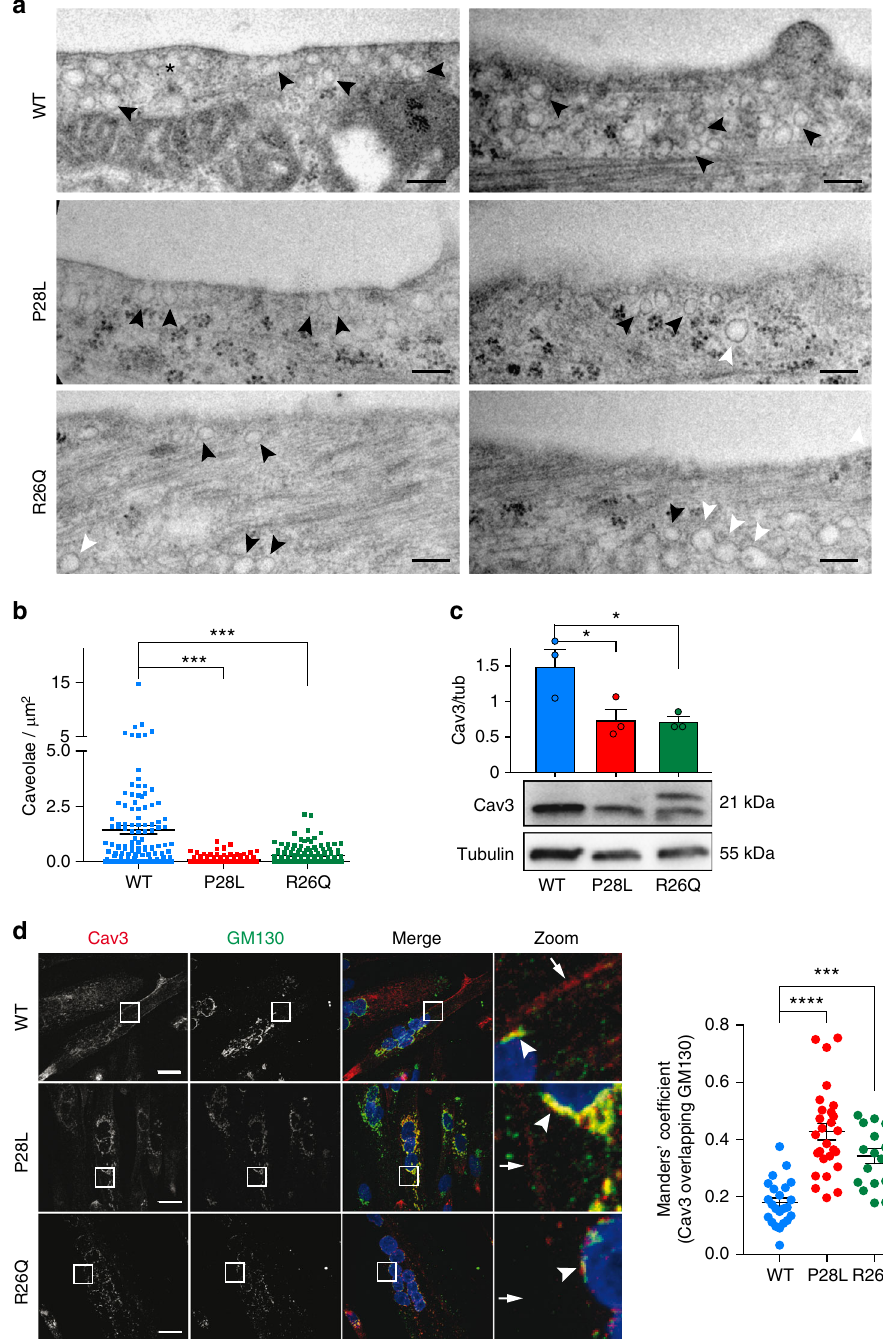
Fig. 1 Characterization of caveolae and Cav3 expression in WT, Cav3 P28L, and Cav3 R26Q myotubes. a Electron micrographs of WT, Cav3 P28L, and Cav3 R26Q myotubes. Caveolae, interconnected caveolae, and aberrant sized caveolae are indicated with black arrowheads, asterisks, and white arrowheads, respectively. b Quanti fi cation of the number of caveolae/ µ m 2 in a . c Immunoblot analysis (lower panel) and quanti fi cation (upper panel) of total levels of Cav3 in WT, Cav3 P28L, and Cav3 R26Q differentiated myotubes. Tubulin serves as a loading control. Quanti fi cation of the expression of Cav3 by calculating the ratio between Cav3 and tubulin expression. d Immuno fl uorescent labeling of Cav3 and GM130 in WT, Cav3 P28L, or Cav3 R26Q myotubes analyzed by confocal microscopy. Arrows in inset indicate the plasma membrane and arrowheads indicate the Golgi complex. Cav1 staining is shown in Supplementary Fig. 1c. a Scale bar = 200 nm. Representative cells quanti fi ed in b (number of regions analyzed: WT = 115, P28L = 154, R26Q = 146; total area screened: WT = 1140 µ m 2 , P28L = 1187 µ m 2 , R26Q = 1216 µ m 2 ). Reproducibility of experiments: a Representative cells. a , c , d Representative data. b , c Quanti fi cation was done on 3 independent experiments. d Quanti fi cation was done on 3 independent experiments (WT n = 24 cells, P28L n = 27 cells, R26Q n = 17 cells). Mean value± SEM. b , c Statistical analysis with a two-tailed unpaired t test. d Statistical analysis with a one-way ANOVA * P < 0.05; *** P < 0.001; **** P <